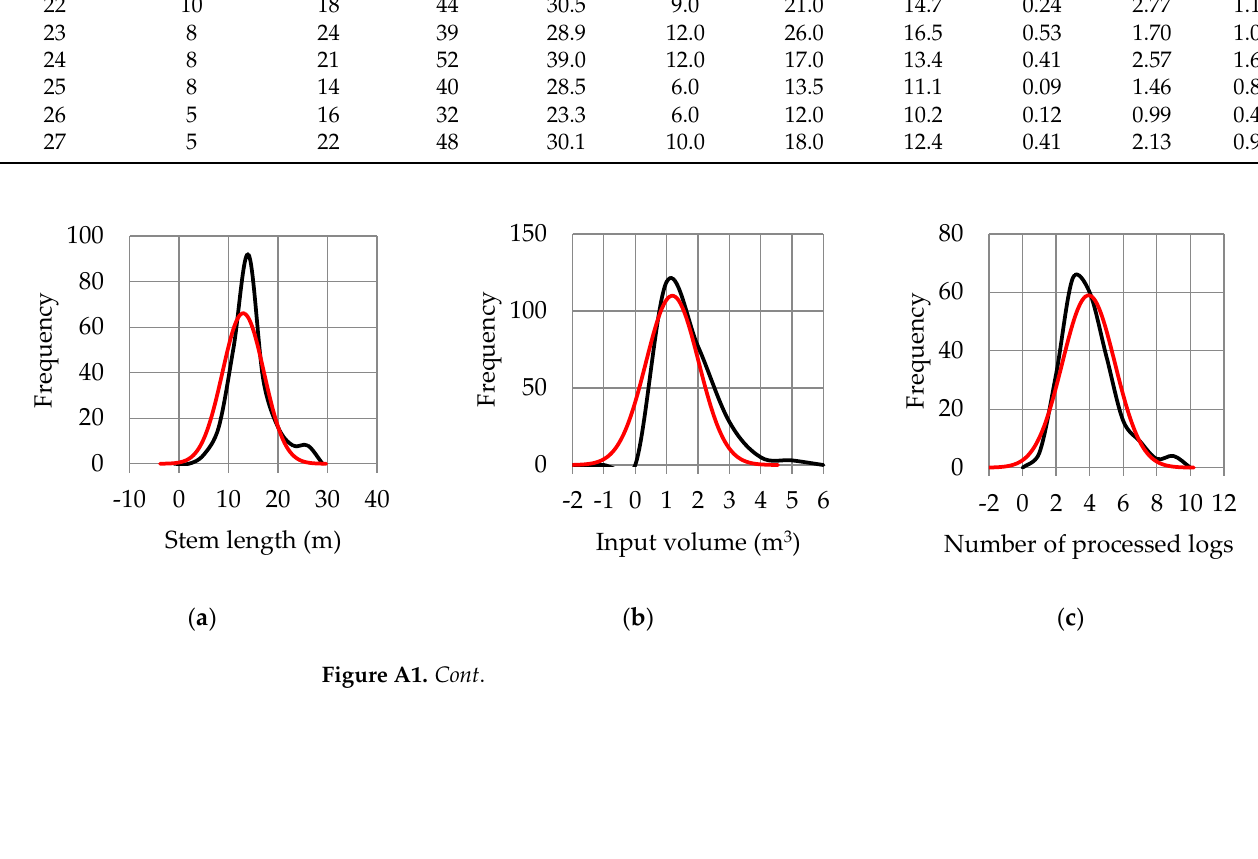
( i ) Figure A1. Experimental versus expected normal data: ( a ) frequency of stem length; ( b ) frequency of input volume; ( c ) frequency of number of processed logs; ( d ) frequency of swinging to grab time; ( e ) frequency of grabbing time; ( f ) frequency of swinging to process time; ( g ) frequency of pro- cessing time; ( h ) frequency of piling time; ( i ) frequency of work cycle time Legend: red lines stand for normal expected data, black lines stand for experimental data; Note: the graphs were built in Real Statistics by “match area” functionalities. None of the datasets has p assed the normality check by Shapiro –Wilk or D’Agostino– Pearson tests.